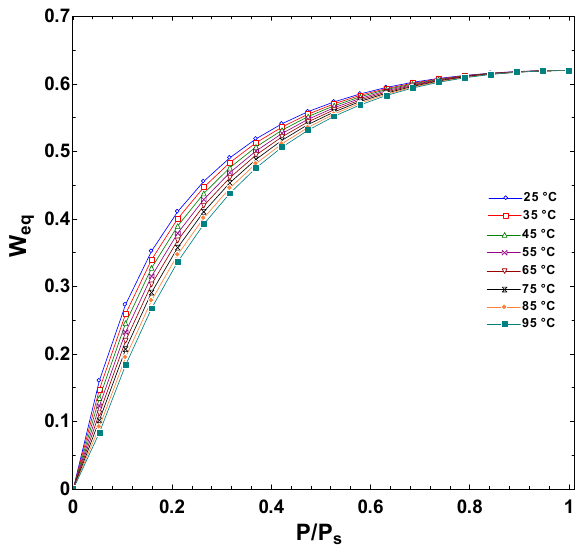
Figure 3. The isotherms of the given consolidated composite adsorbent/ethanol pair.